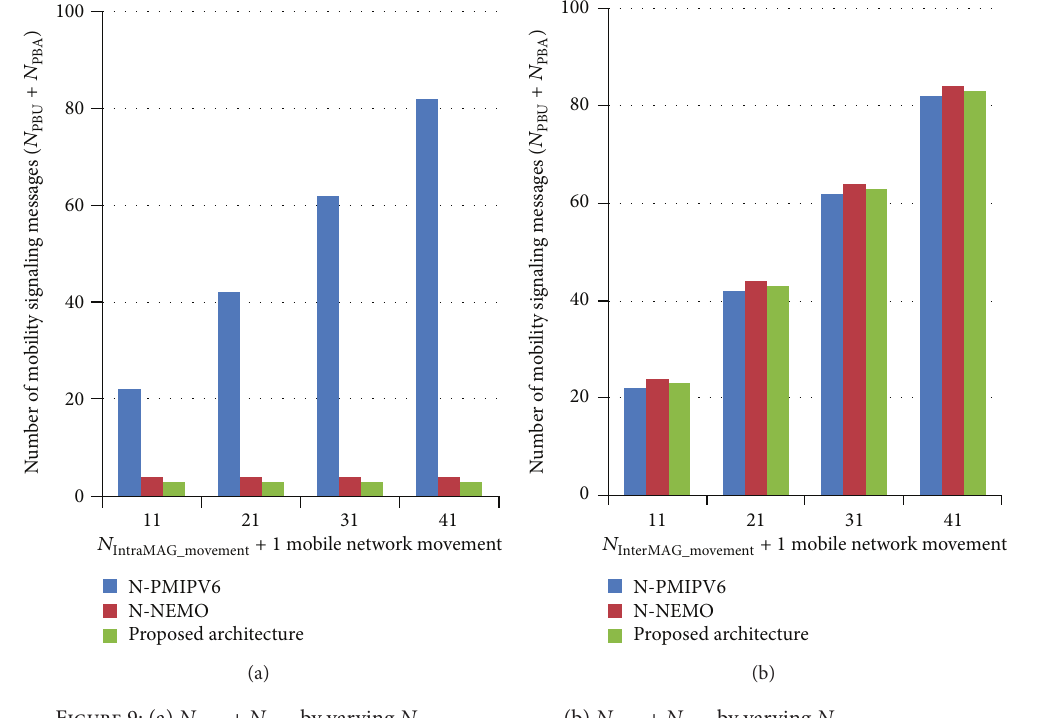
Figure 9: (a) 𝑁 PBU + 𝑁 PBA by varying 𝑁 IntraMAG movement . (b) 𝑁 PBU + 𝑁 PBA by varying 𝑁 InterMAG movement . Table 1: 𝑁 and 𝑁 exchanged during MNN/mobile network PBU PBA